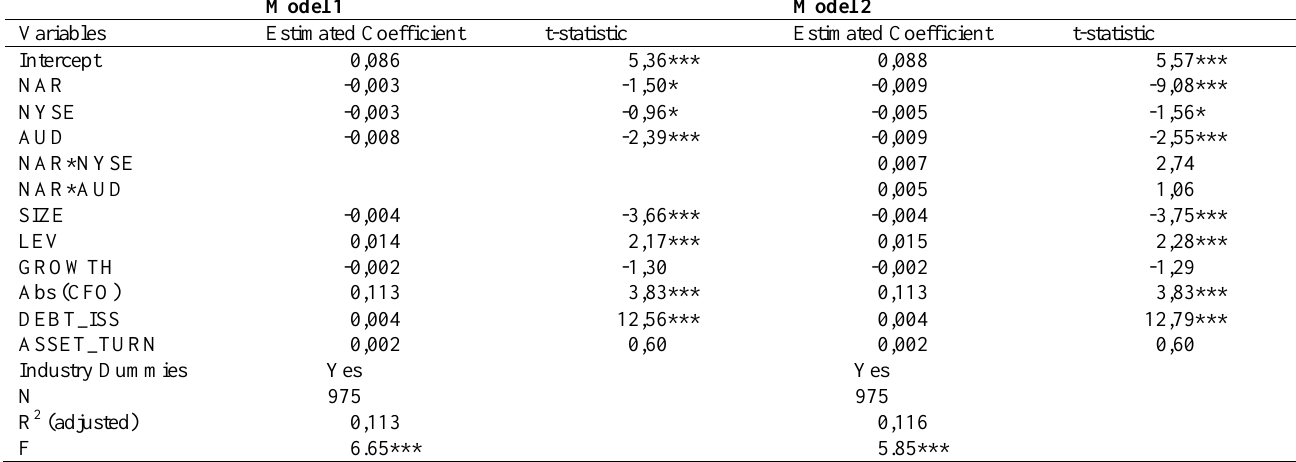
Table 9: Regressions of absolute discretionary accruals on independent variables and control variables. Kothari Model (sensitivity